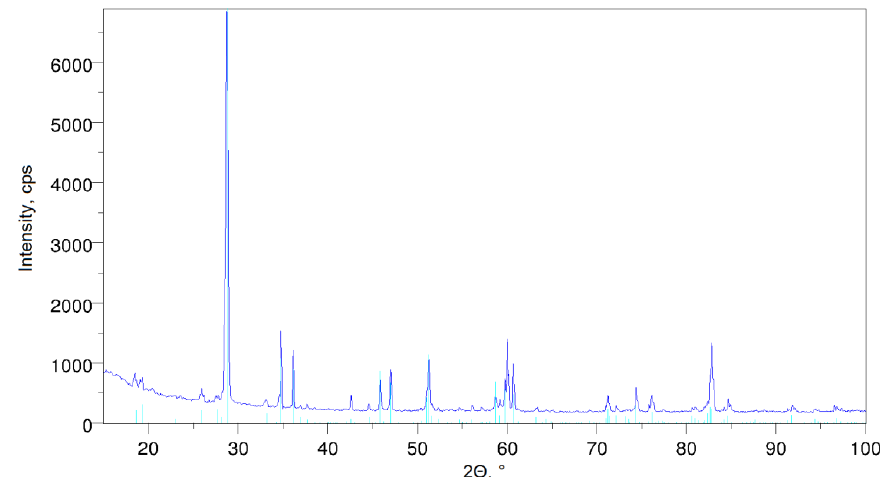
Figure 7. X-ray powder diffraction (XRD) patterns of cesium perrhenate crystals. (dark blue—sample pattern; light blue—database data). Table 7. Results of CsReO 4 crystallisation tests.